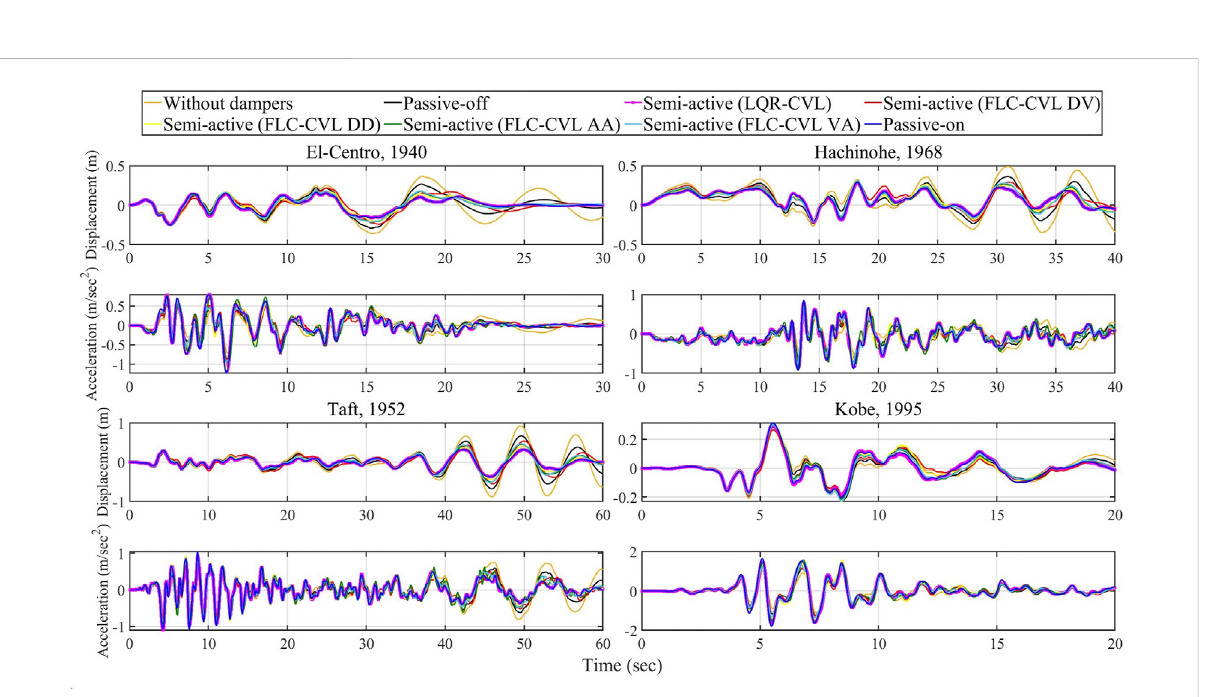
FIGURE 10 Time-history response of the top fl oor of the main